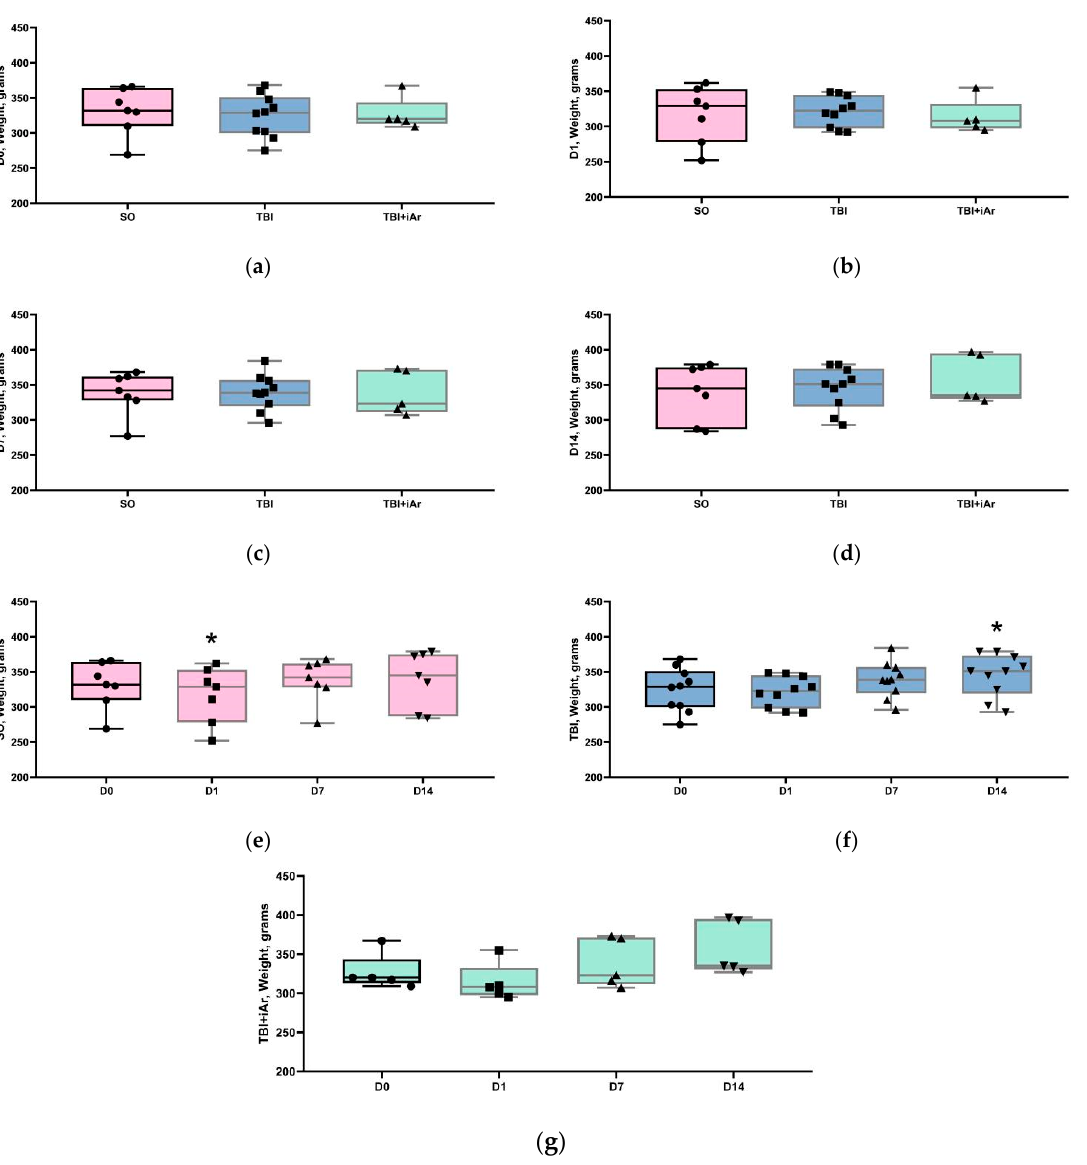
Figure 1. Analysis of body weight data. ( a ) Weight of rats the day before the simulated TBI; ( b ) weight of rats on the day of the simulated TBI; ( c ) weight of rats 7 days after the simulated TBI; ( d ) weight of rats 14 days after the simulated TBI; ( e ) weight change in the control group; (f) weight change in the TBI group; ( g ) weight change in the TBI + iAr group. The data are presented as median, quartiles, and single values. *— p < 0.05 vs. D0, Kruskal–Wallis test with Dunn’s multiple comparisons. ■ ; ● ; ▲ ; ▼ —single values within specific statistical sample.